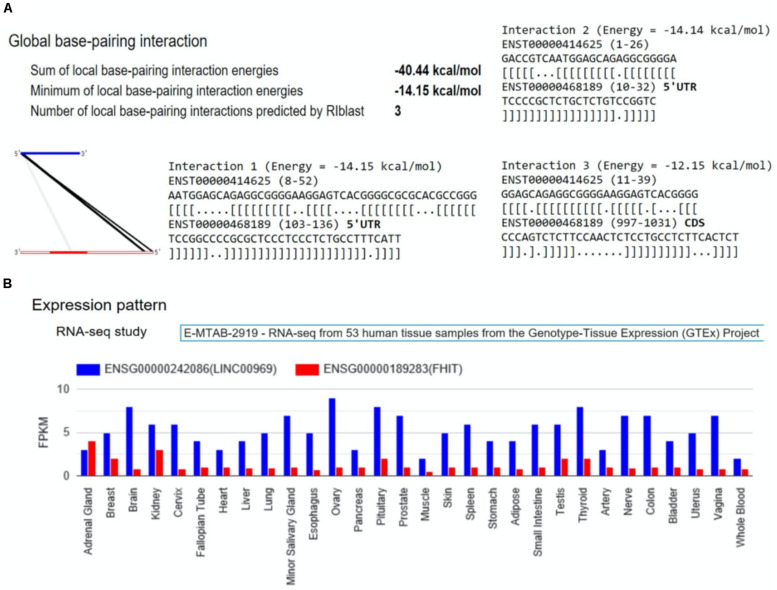
The output of LncRRIsearch (Fukunaga et al., 2019) for the interaction of the transcripts of LINC00969 and FHIT. (A) The graphical and text view of the global base -pairing interactions of LINC00969 and FHIT predicted by RIblast (Fukunaga and Hamada, 2017); (B) The expression pattern of LINC00969 and FHIT in RNA-seq data of GTEx consortium (E-MTAB-2919) (Lonsdale et al., 2013). LINC00969 and FHIT were represented by blue color and red color respectively.